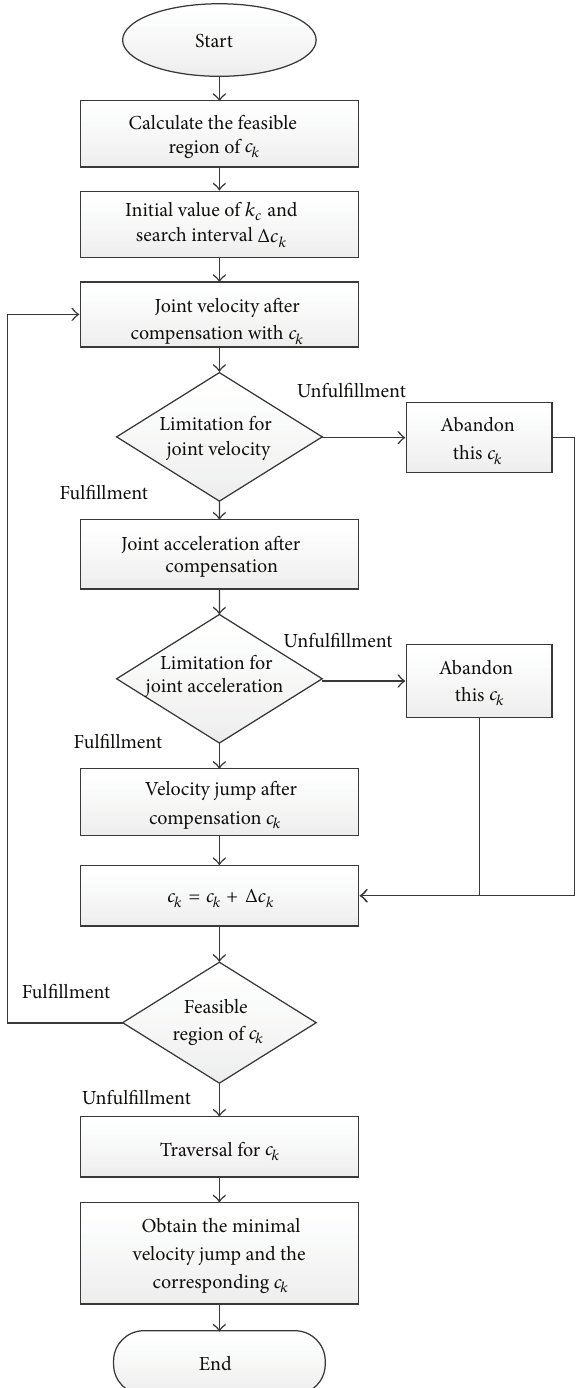
Figure 2: Process of finding the optimal 𝑐 𝑘 when joint fails at a particular